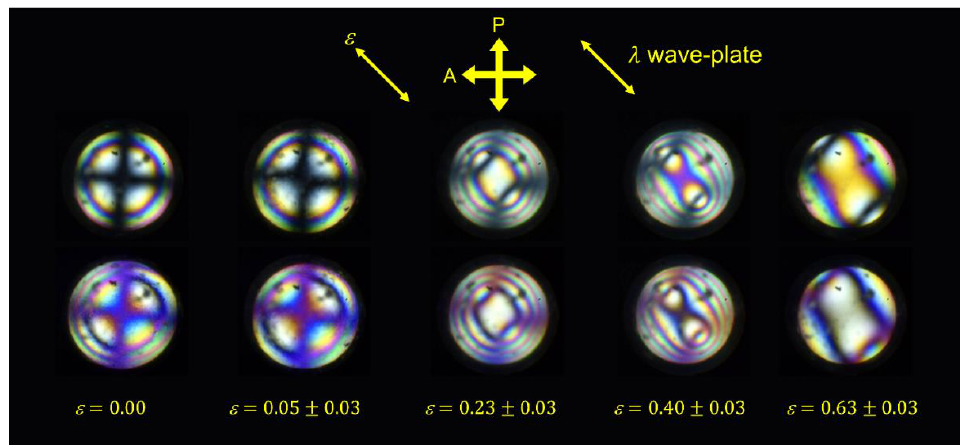
Figure 10. Conoscopic figures for the homeotropically aligned LCE strained at 45 ◦ to the crossed- polarizers. The top and bottom rows show the conoscopic images without and with a λ -wave-plate inserted, respectively.